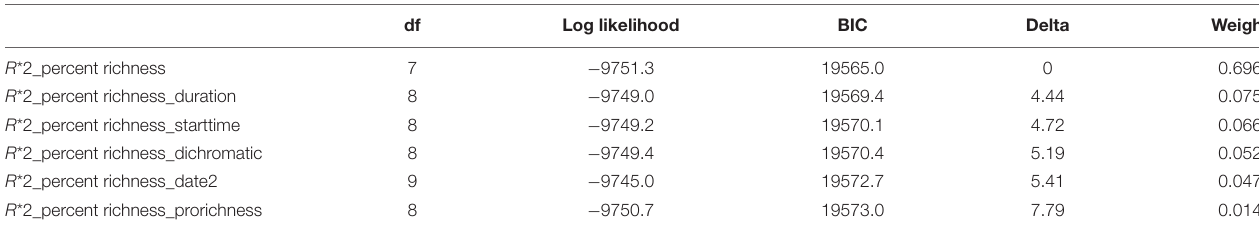
TABLE 2 | Model results of variables most influential on percent